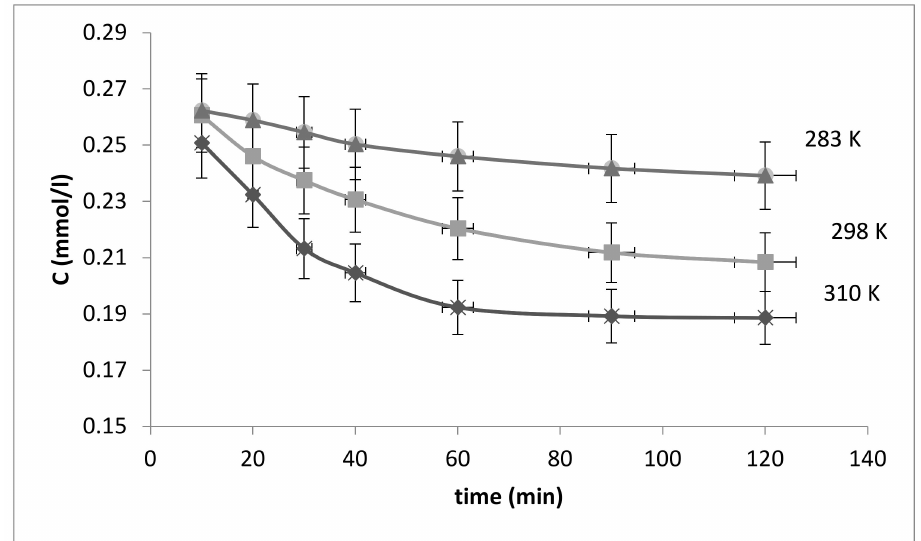
Figure 4. Kinetic curves of fluoride adsorption from solution by the bacterial cellulose-based modified sorbent (ratio of adsorbate–adsorbent solution 1000:1 (mL/g)).